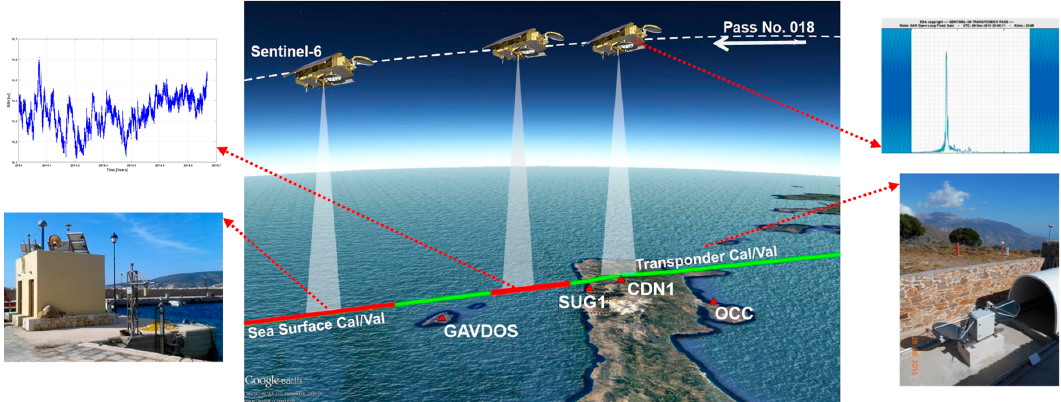
Figure 7. The transponder and sea-surface calibrations as applied in Crete and Gavdos for the satellite altimeters.